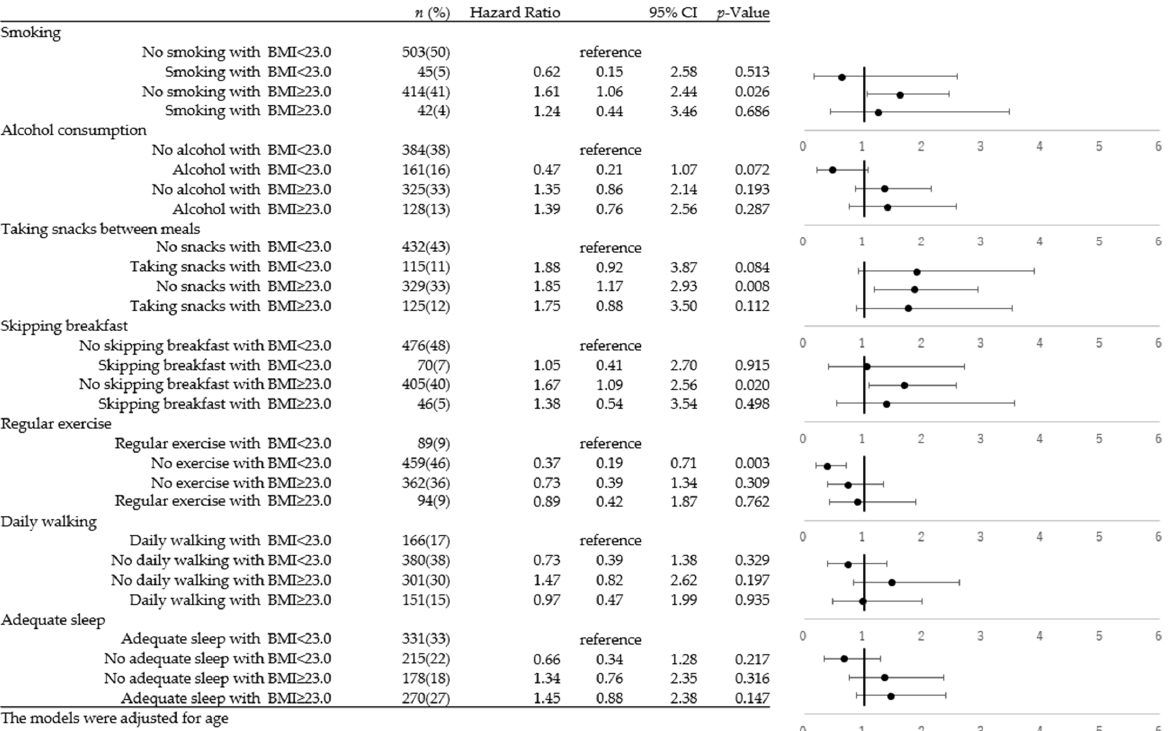
Figure 3. Cox proportional hazard model of the combination of BMI and lifestyles and the progres- sion of kidney damage among females. of kidney damage among